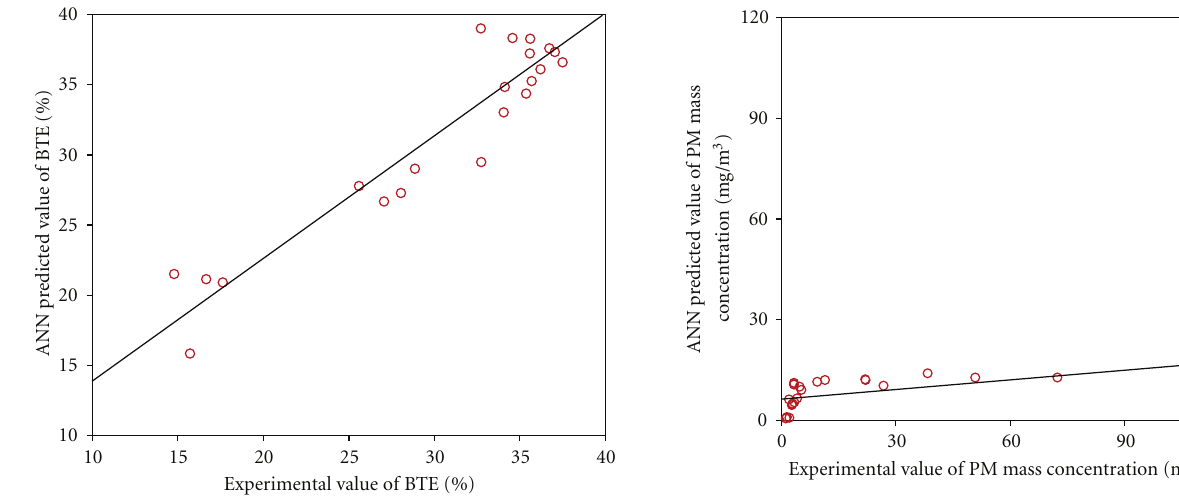
Figure 11: Comparison between ANN predicted values and the corresponding actual values for PM mass